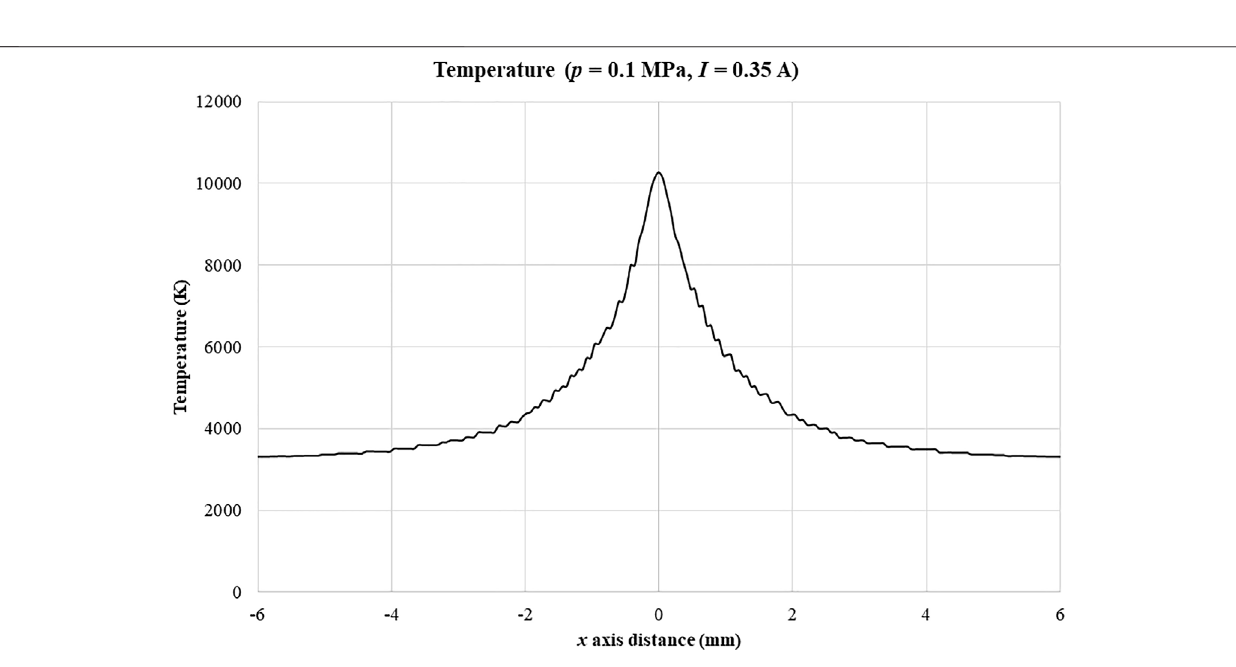
Frontiers in Physics |